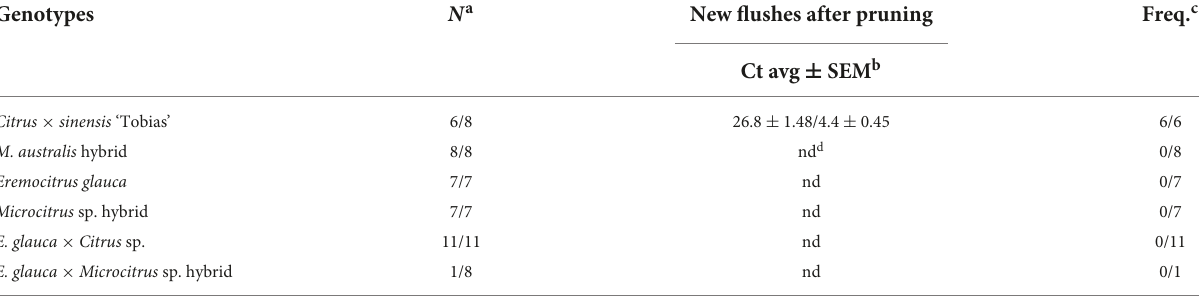
TABLE 7 ‘ Candidatus Liberibacter asiaticus’ detection in new flushes from Oceanian citrus genotypes and ‘Tobias’ sweet orange as scions onto Las-infected ‘Rangpur’ lime rootstocks, one month after drastic pruning of the canopy at 5 cm above the scion-rootstock union.